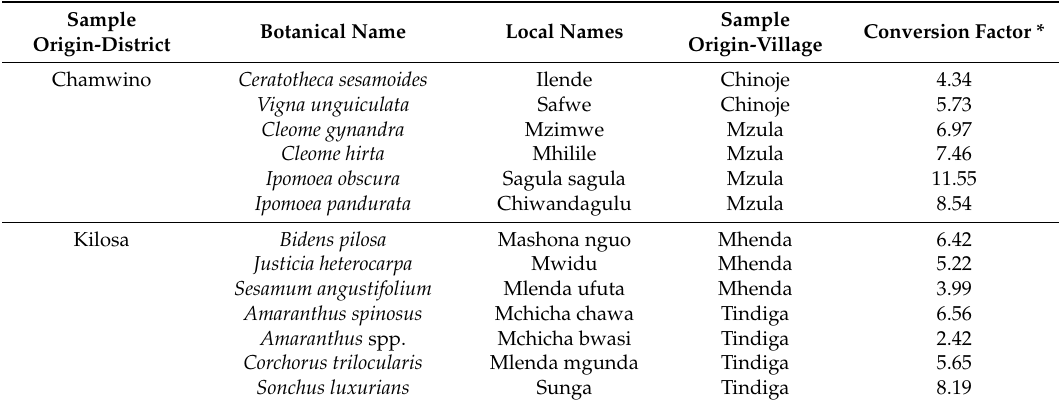
Table 1. Vegetable samples origin and their conversion